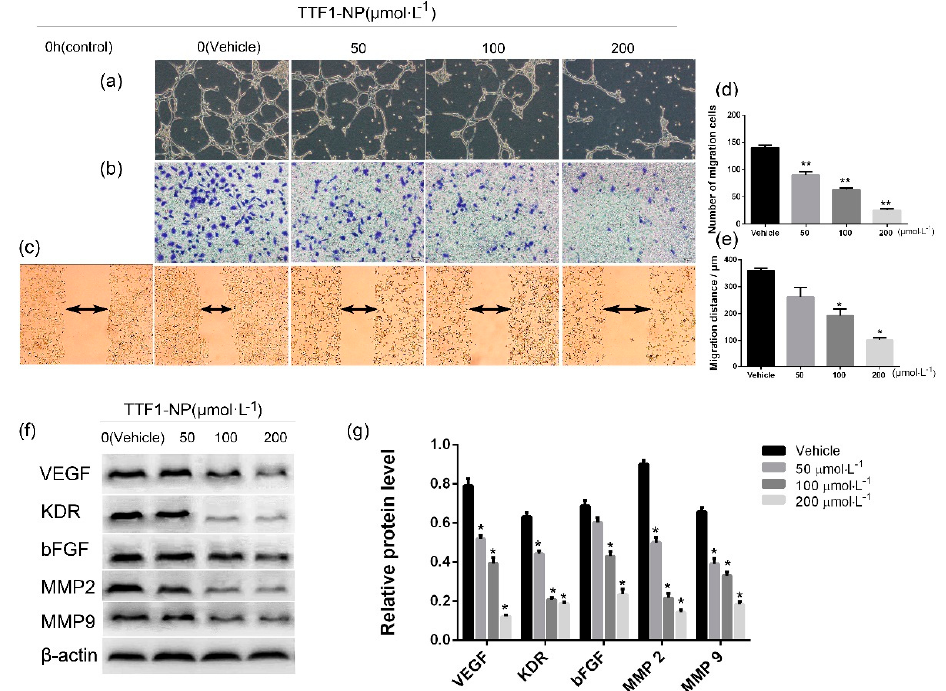
Figure 2. TTF1-NP inhibited HUVEC tube formation and HepG2 cell migration and invasion and downregulated the expression levels of related proteins. ( a ) Tube formation assay with HepG2 cells treated with indicated concentration of TTF1-NP (100 × magnification); ( b ) transwell assays with HepG2 cells treated with indicated concentration of TTF1-NP (200 × magnification); ( c ) Scratch healing